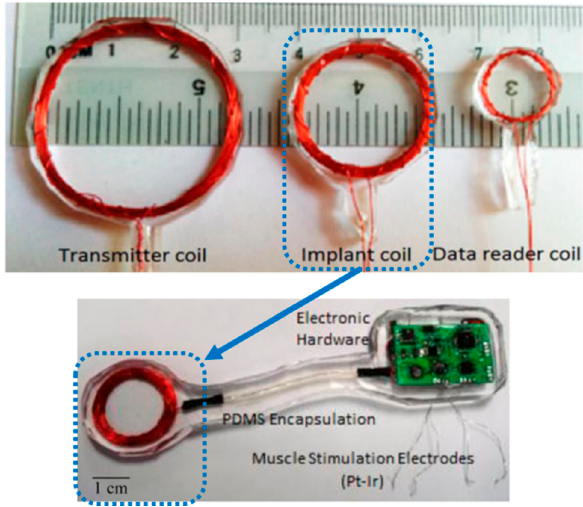
Figure 12. Different coils and stimulation implant used in the rat experiment [111]. Copyright © 2015, IEEE.